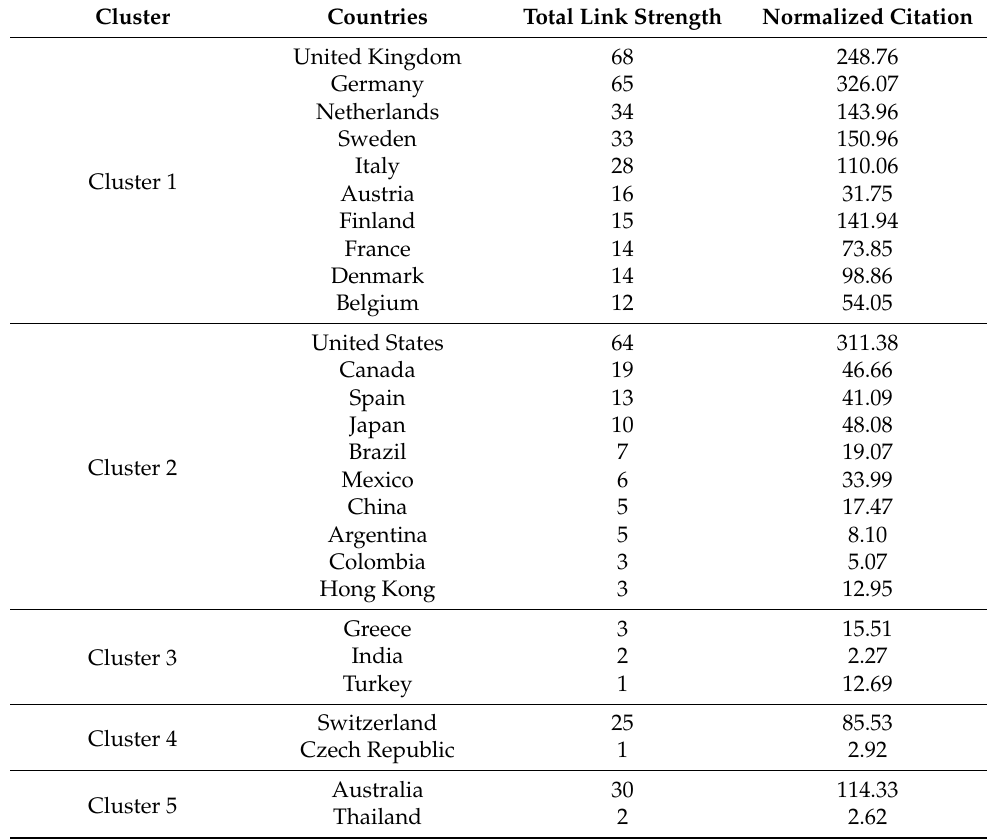
Table 6. Top 10 countries in each cluster based on co-authorship network analysis during the period 1990–2020 (sorted by total link